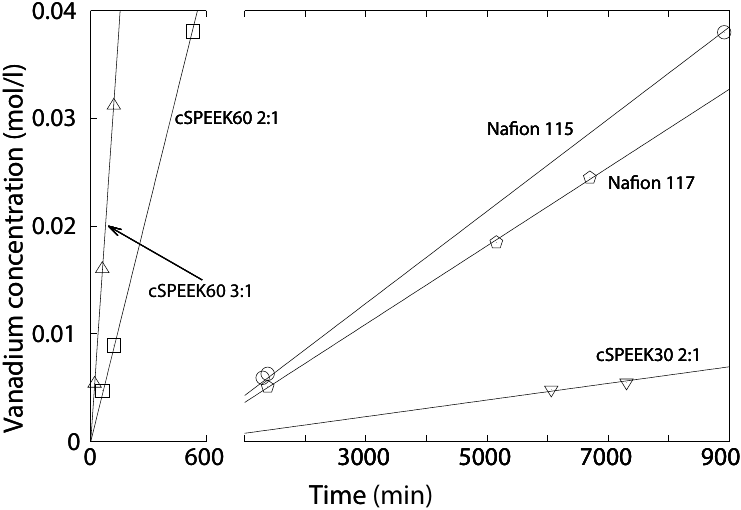
VO 2+ crossover through cSPEEK membranes cured at 200 °C and Nafion membranes sample code: cSPEEK60 2:1 = crosslinked SPEEK with a crosslinking time of 60 min and a SPEEK:crosslinking ratio of 2:1).